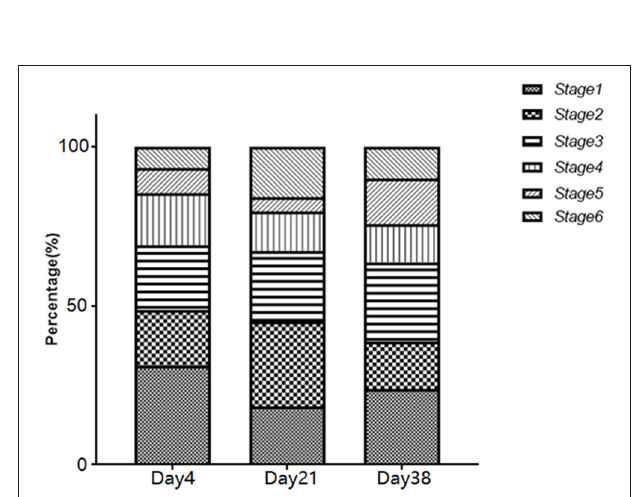
FIGURE 1 | The concentration of airborne fungi in the poultry houses measured at different stages using the Andersen six-stage sampler. Data are expressed as the means ± SDs, *** P < 0.001 compared between the two groups ( n = 9).